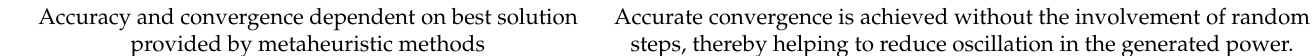
Table 1. Issues in the existing MPPT algorithms and the contributions of the proposed algorithm. Issues in Existing MPPT Techniques for WECS Contribution of the Proposed MPPT Algorithm Simple tracking approach, employing trapezoidal-rule-based perturb Complex tracking and observe algorithm Higher computational complexity Reduced computational complexity Accuracy and convergence dependent on best solution Accurate convergence is achieved without the involvement of random provided by metaheuristic methods steps, thereby helping to reduce oscillation in the generated